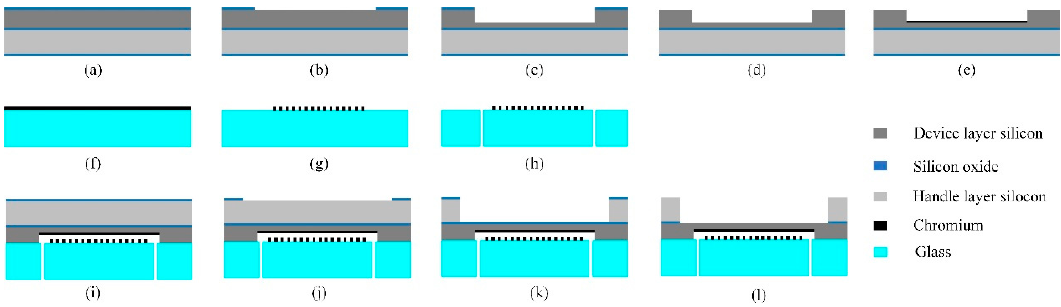
Figure 2. Micro-Electro-Mechanical System (MEMS) process of the acoustic sensor chip.